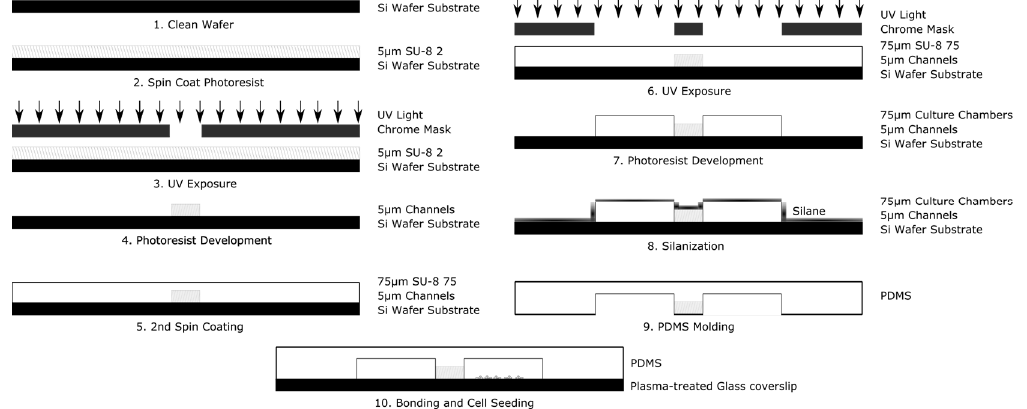
Figure 3. Schematic illustration of the principle steps used in the fabrication of the Gal-MµS device.